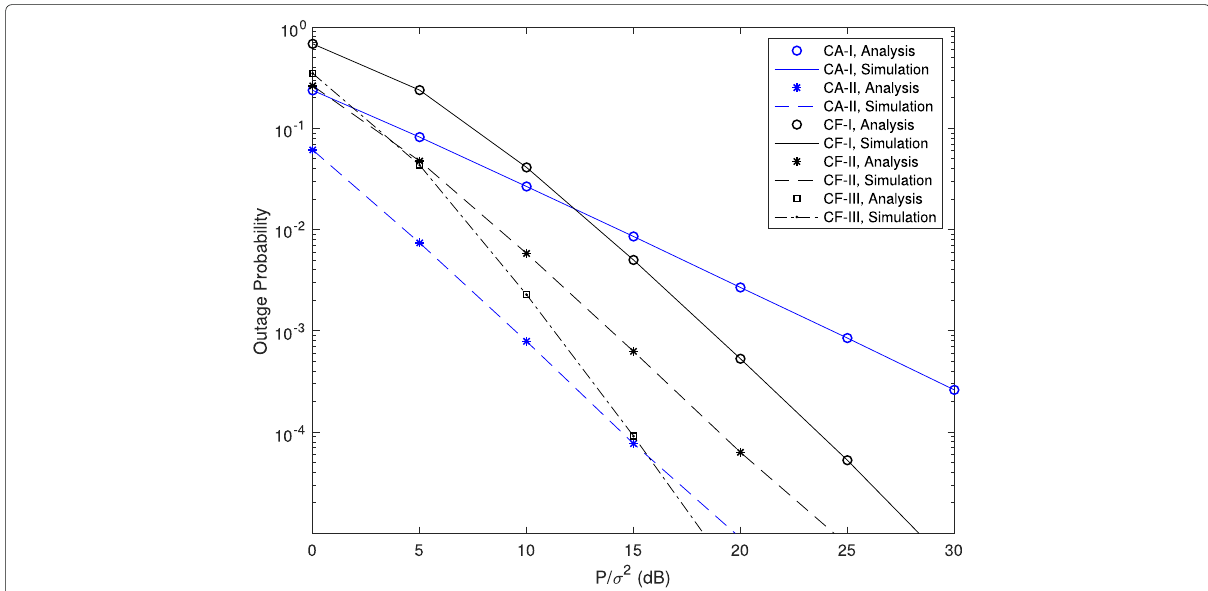
Fig. 2 Outage probability versus P /σ 2 when N = 2, L = 50Mbits, K = 10, B = 100MHz and T =